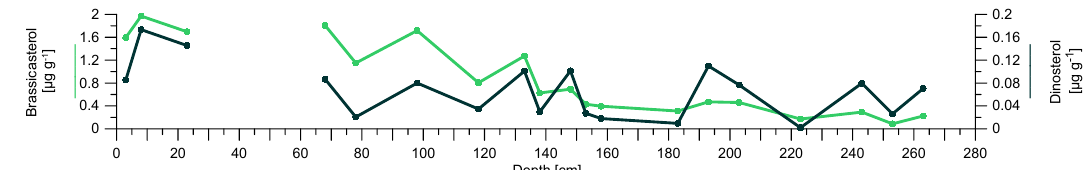
Figure A5. Phytoplankton biomarker (µgg − 1 sediment): brassicasterol (light green line) and dinosterol (dark green line). Note almost parallel trend with brassicasterol showing values 1 magnitude higher than